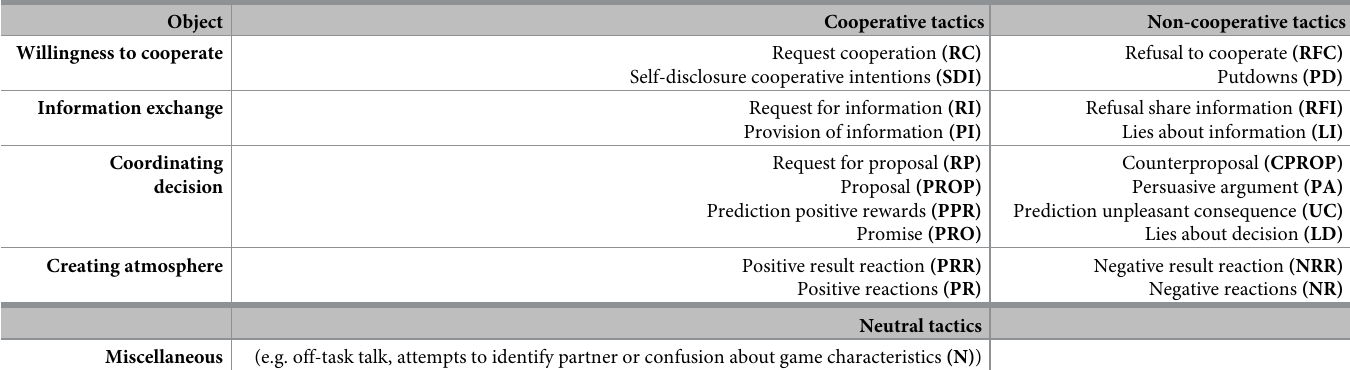
Table 1. Communication coding